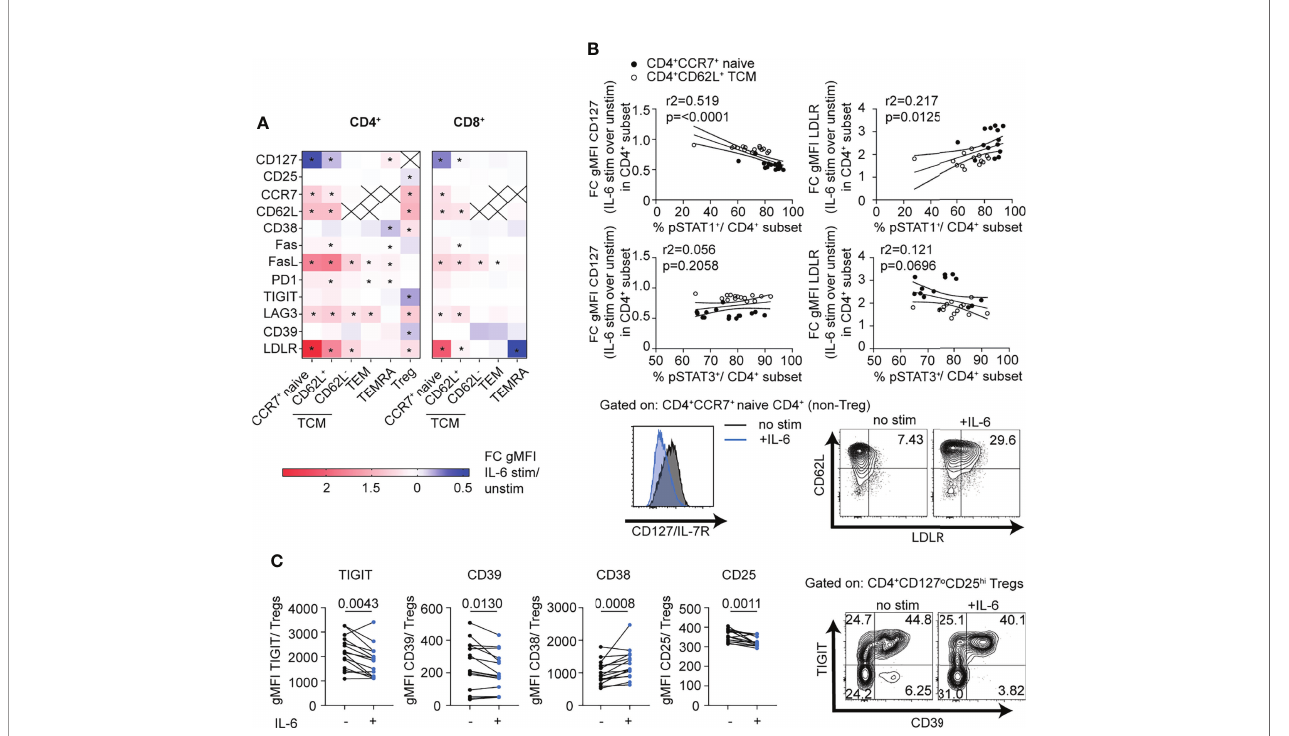
FIGURE 4 | mbIL-6R signaling induced pSTAT1 responses are linked to T cell subset speci fi c phenotypic changes. CD3-enriched T cells were stimulated with IL-6 (20 ng/mL) or left unstimulated for 24 h, and then change in expression levels of selected surface markers was determined via fl ow cytometry. (A) Heatmap showing the fold change in surface gMFI expression levels of selected markers following IL-6 stimulation over the unstimulated control in distinct CD4 + and CD8 + T cell subsets. (B) Simple linear regression analysis of the fold change in CD127 (left) and LDLR (right) expression and the magnitude of the pSTAT1 (top) and pSTAT3 (bottom) responses following IL-6 stimulation in naïve CD4 + (black dots) or CD62L + TCM (white dots) cells and representative fl ow plot of IL-6 driven changes in CD127 and LDLR expression on gated naïve CD4 + T cells (bottom). (C) Paired analysis of gMFI expression levels of TIGIT, CD39, CD38, and CD25 among gated CD127 lo CD25 hi Treg cells in the presence (+) or absence (-) of IL-6 stimulation. (A) 2-way ANOVA and Bonferroni ’ s multiple comparisons test, * FDR p < 0.05. (B) Linear regression analysis with Pearson ’ s correlation coef fi cients. (C) Wilcoxon matched-pairs signed rank test. n =